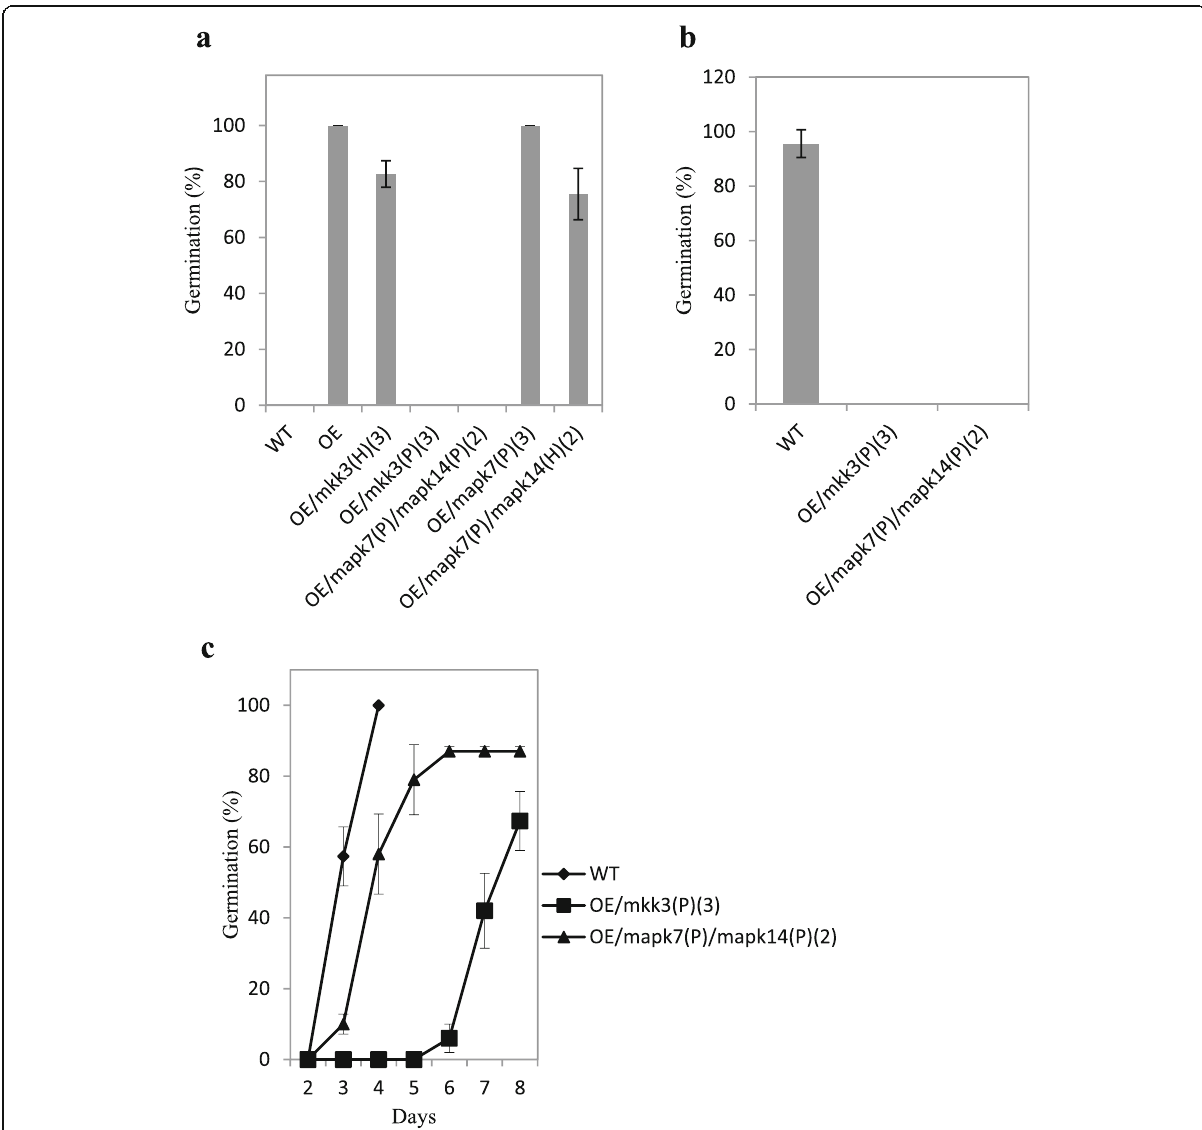
Fig. 5 Germination phenotype of knockout progenies. a, At 23 DAH, seeds were collected from different knockout progenies and germination percentage was calculated at 2 DAI. b, At 30 DAH, seeds were collected from homozygous knockout progenies and germination percentage was calculated at 5 DAI. c, Time course of germination of homozygous OE/ mkk3 and OE/ mapk7/mapk14 seeds after storage at 37 °C for 1 month. mkk3, MKK3 knockout plant; mapk7, MAPK7 knockout plant; mapk14, MAPK14 knockout plant; P, homozygous positive; H, heterozygous; Number in parentheses indicates number of knockout lines. Values are mean ±